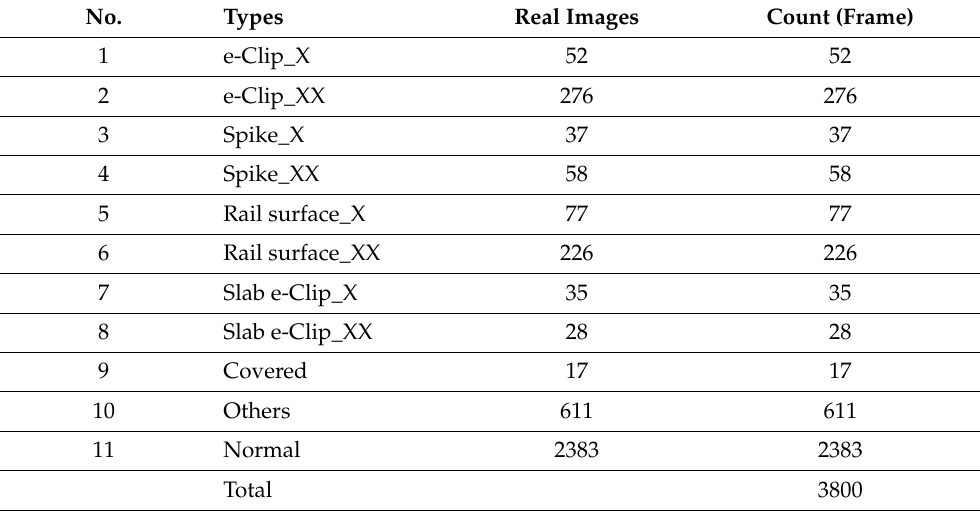
Table 3. Top-view dataset.